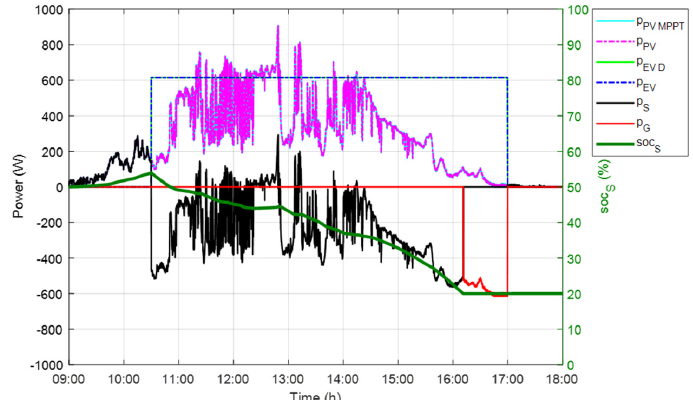
Figure 9. Scenario 1b, system power flows and stationary storage SOC evolution.